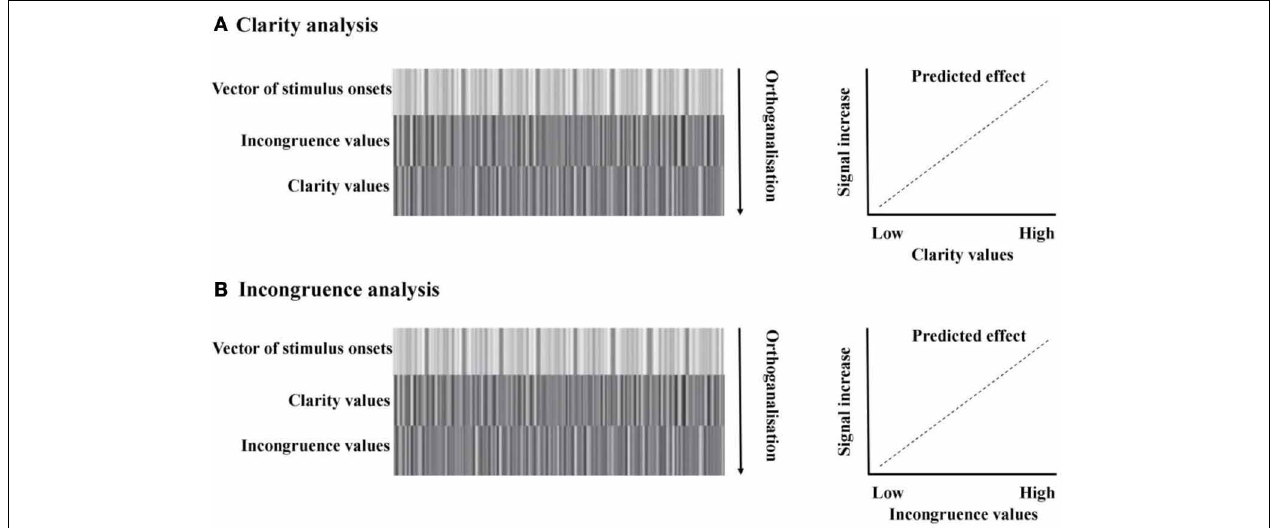
FIGURE 3 | fMRI analysis models. (A) Clarity analysis. The design matrix included one vector modeling all the onsets of the audiovisual stimuli, then two parametric modulators: the first modeling the incongruence value of each stimulus, and the second modeling the clarity value of each stimulus. Parametric modulators were serially orthogonalized, meaning that any variance associated with incongruence was removed. The linear expansion of the parametric modulator predicted that, with a positive loading on the modulator, as clarity values increased, there would be a related increase in